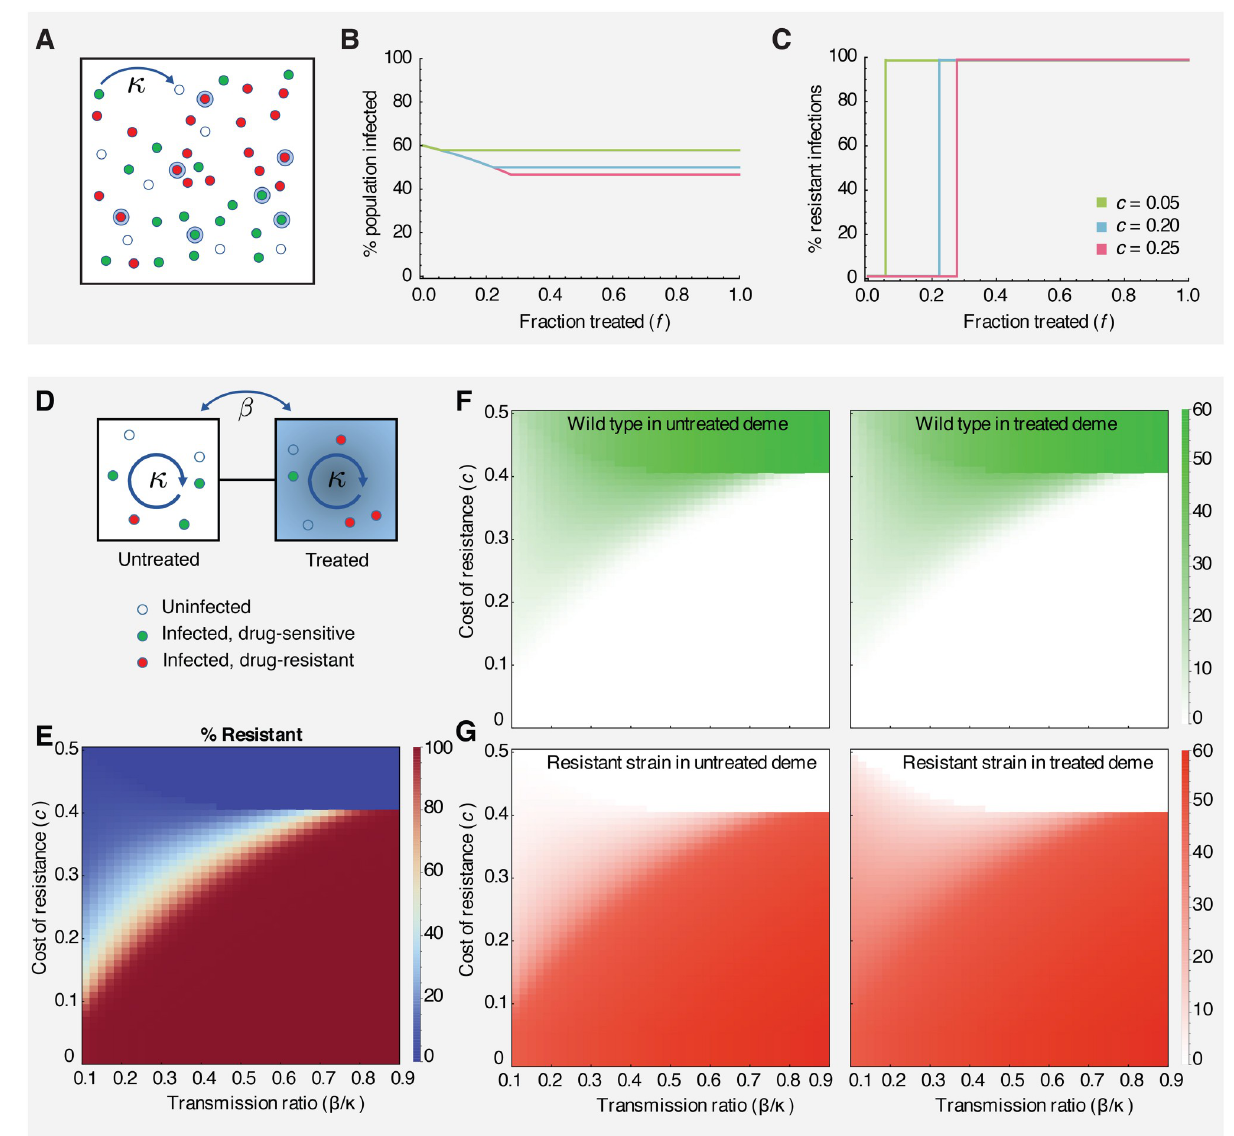
Fig 3. Competition between drug-sensitive and drug-resistant strains in a single well-mixed population (A-C) and two interconnected subpopulations (D-G). A) A population of individuals in a single well-mixed deme, in which a fraction f receive drug treatment (blue haloes). Individuals may be uninfected (hollow blue circles), or infected with either the wild-type (green circles) or drug-resistant (red circles) strain. B) The total prevalence of infection (wild-type + drug-resistant) as a function of the fraction of treated individuals ( f ) for different costs of resistance ( c ). C) The % of infections that are drug-resistant as a function of the fraction of treated individuals ( f ) for different parameters. Infection switches between 0% and 100% resistant when f = c / � . Coexistence never occurs. D) Schematic of a two-deme population (left-untreated, right-treated) and the two strains (green-wild type, red-resistant) considered in the model. E-G) Each panel shows the infection level (shading) as a function of the relative connectivity between demes ( β / κ ) and the cost of resistance ( c ). E) The % of all infections that are drug-resistant strain across the entire population. F) The % of individuals in each deme who are infected with the wild type strain. G) The % of individuals in each deme who are infected with the resistant strain.For all results, the transmission rate is κ = 0.25/day, the recovery rate is g = 0.1/day, and the treatment efficacy is � = 0.9. treatment, while individuals in the other deme are never treated. The system is described by a set of equations tracking the proportion of individuals of each infection status (uninfected, infected with drug sensitive, infected with drug resistant) in each deme (treated vs untreated). The basic reproductive ratio can be derived for each strain ( R w and R r ) (see Methods). 0 0